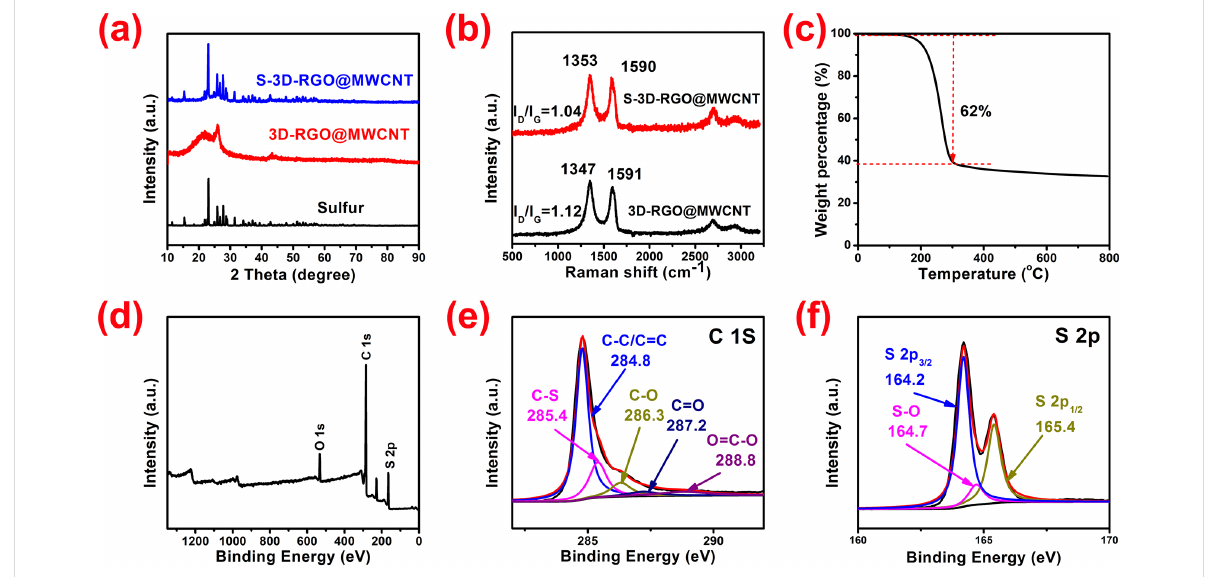
Figure 4: (a) XRD patterns of sulfur, 3D-RGO@MWCNT and S-3D-RGO@MWCNT; (b) Raman spectra of 3D-RGO@MWCNT and S-3D- RGO@MWCNT; (c) TGA of S-3D-RGO@MWCNT; (d) The XPS survey spectrum of S-3D-RGO@MWCNT composite; high-resolution XPS spectra of (e) C 1s, (f) S 2p.